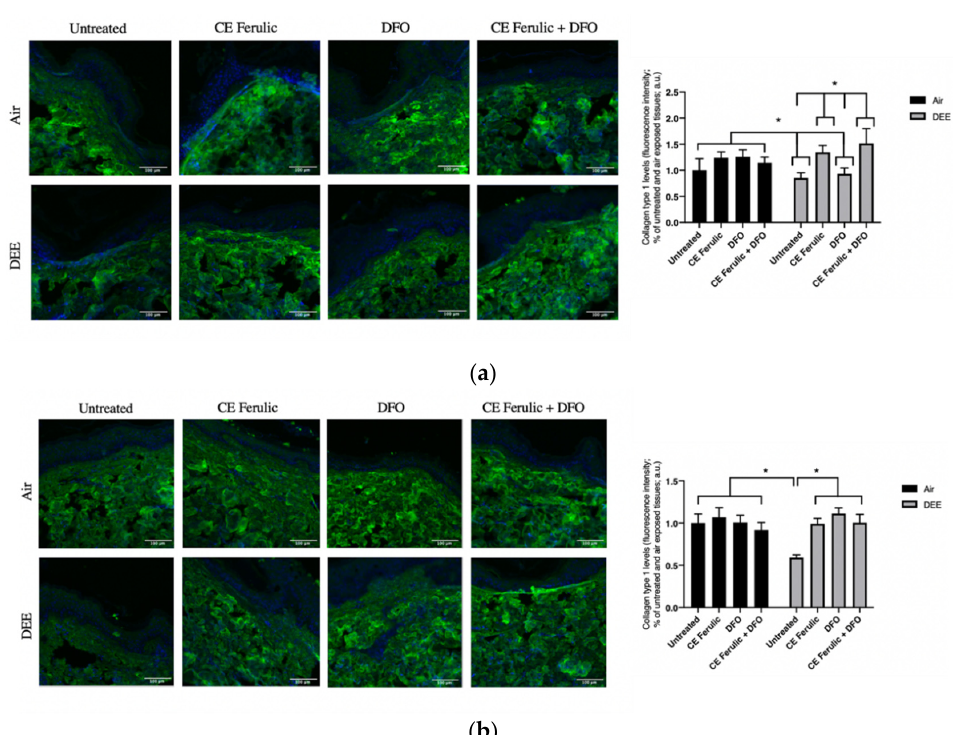
Figure 4. Skin exposure to DEE decreases levels of collagen 1, but topical application of CE Ferulic and DFO prevents this effect. Levels of collagen 1 in ex vivo human skin explants untreated or pretreated with the cosmeceutical formulation mixture and DFO, alone or in combination, and exposed to air or DEE at Day 1 ( a ) and Day 4 ( b ). Green fluorescence staining represents collagen 1 immunoreactivity, while cell nuclei are stained in blue with DAPI. Original magnification 40×. On the right, semi-quantification of the immunofluorescence intensities performed by ImageJ are shown in the histograms. Data are expressed as arbitrary units (averages of three independent experiments), * p < 0.05, by ANOVA. Scale bar = 100 μ m.